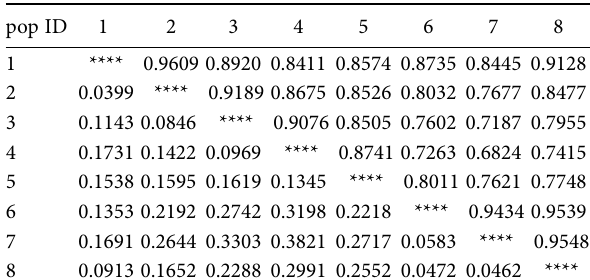
Table 3. Nei genetic identity versus genetic distance in the Z. Jujube populations (populations numbers are according to Fig1. Nei’s genetic identity (above diagonal) and genetic distance (below diago- nal).